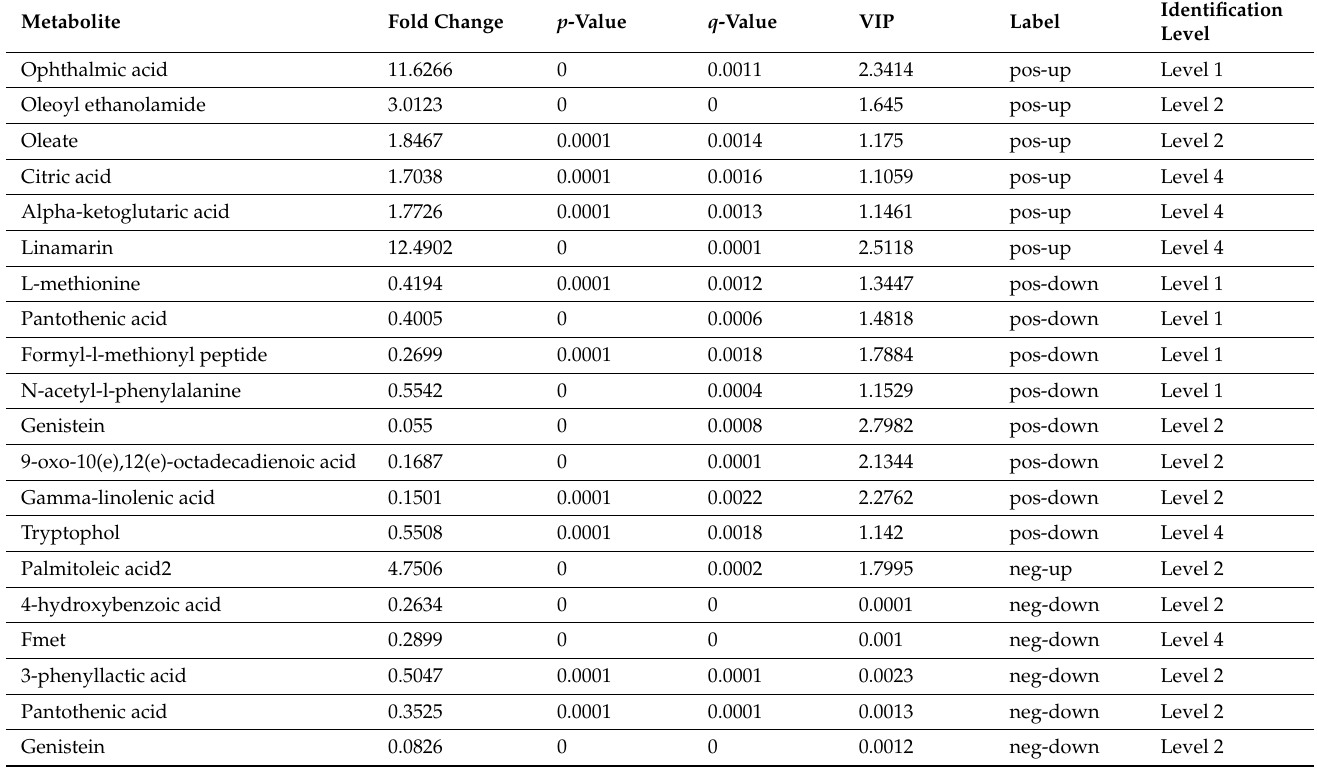
Table 1. Candidate markers identified from metabolomic profiling (pos-up: the up-regulated metabolites in positive mode; pos-down: the down-regulated metabolites in positive mode; neg-up: the up-regulated metabolites in negative mode; neg-down: the down-regulated metabolites in negative